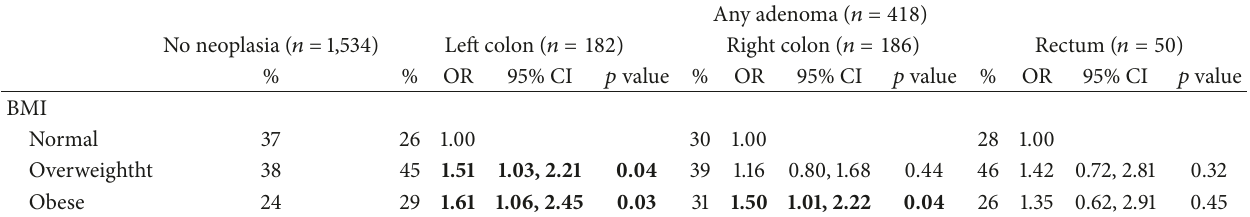
Table 6: Odds ratios for any adenoma by location, related to BMI, adjusted for age, sex, and smoking